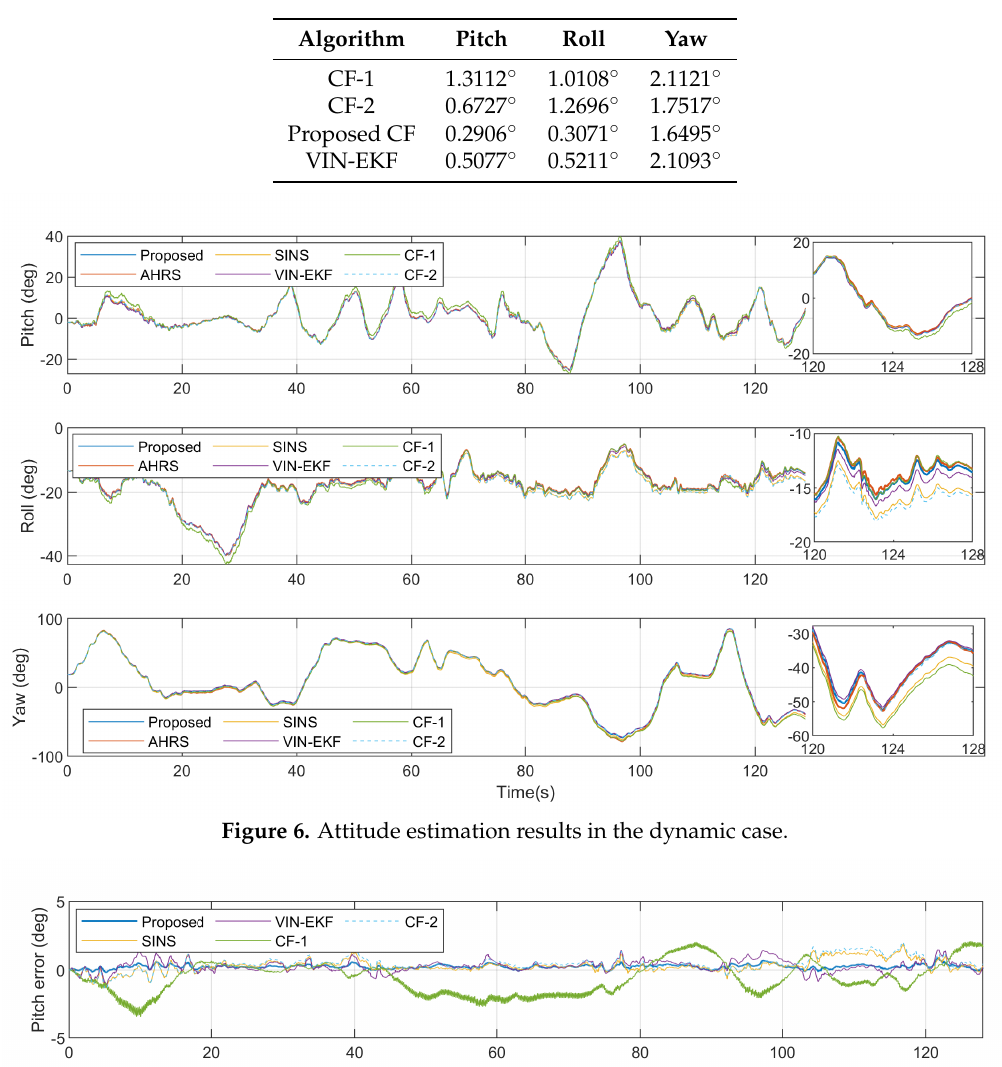
Table 2. RMSE of attitude angles in the dynamic case.